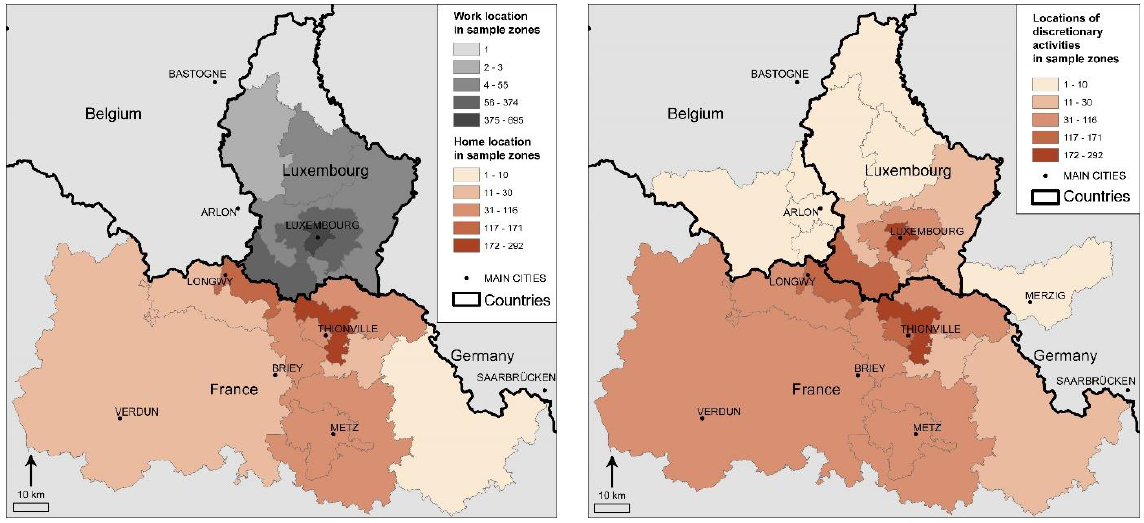
Figure 2. Spatial distribution of the locations of residence, workplaces and discretionary activities in the Luxembourg case study area. Left: locations of home and workplace; Right: locations of discretionary